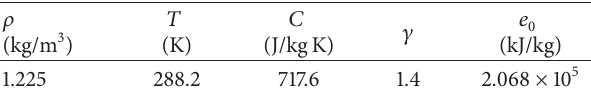
Table 4: Material properties of air